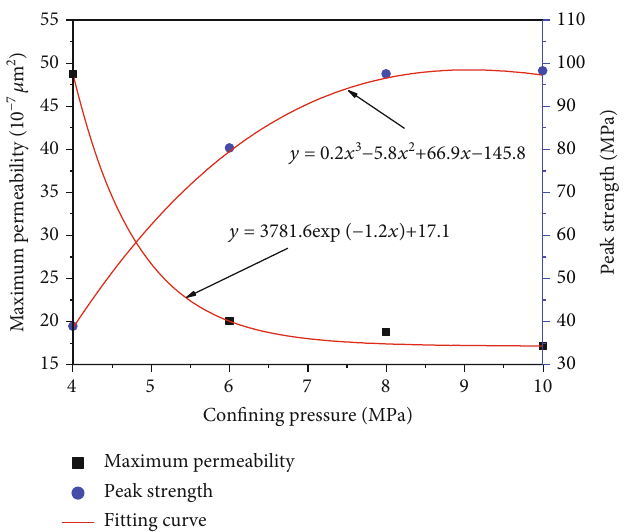
Figure 4: The relationships between maximum permeability and peak strength of sandstones and con fi ning pressure.